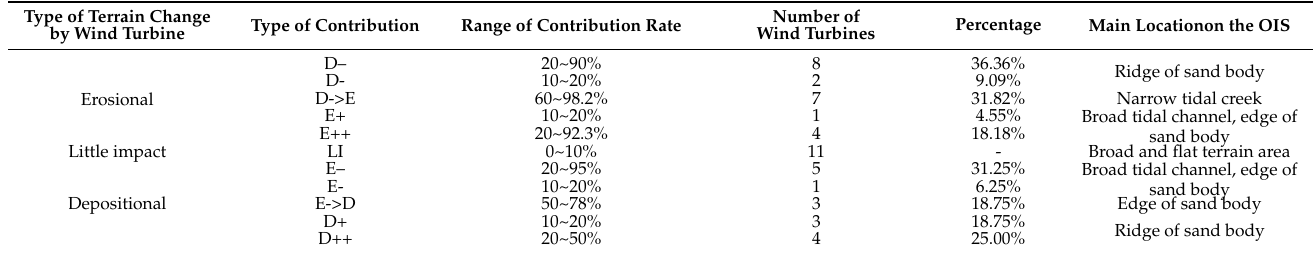
Table 2. Different types of contributions that wind turbines exerted on the terrain